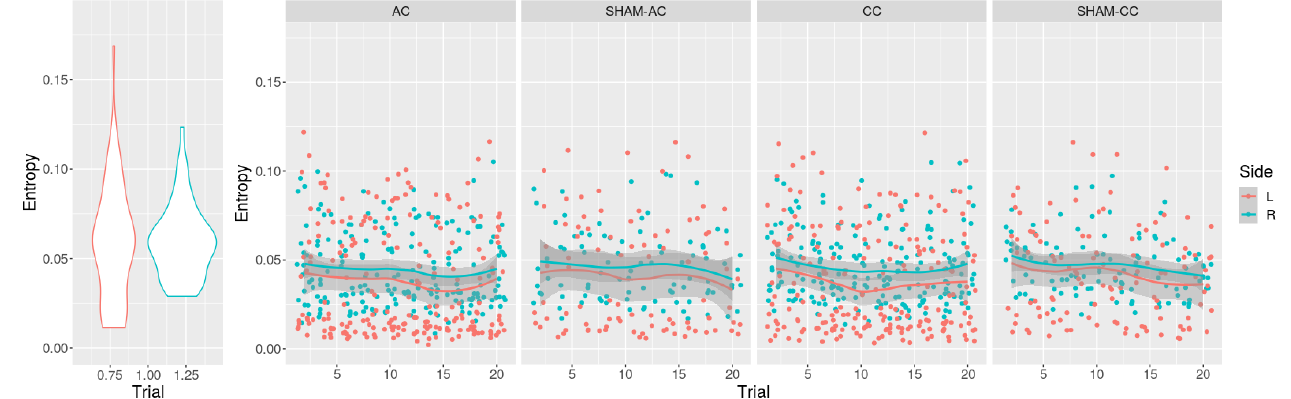
Figure 5. The left-hand plot shows the baseline entropy. The other plots show the time-varying pre/post stimulation entropy responses (off-line) across different montages, per side. The visual- ization adopted the LOESS smoothness, which shows that all montage presents equivalent mean entropy response regardless of its side (Left → Right represented by L, and Right → Left by R), therefore, showing no carryover